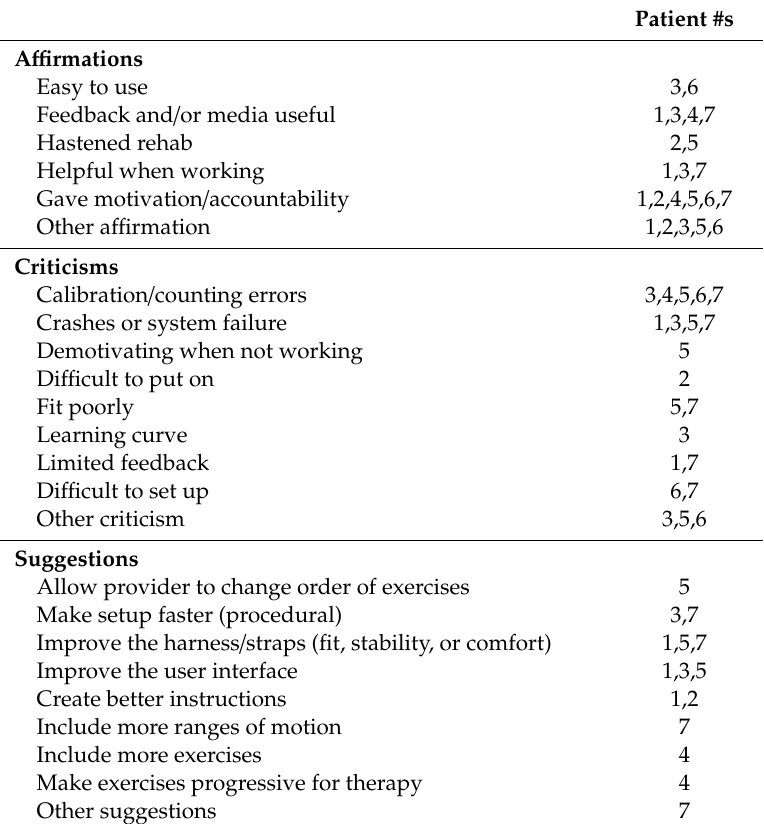
Table 7. Patient interviews (n =